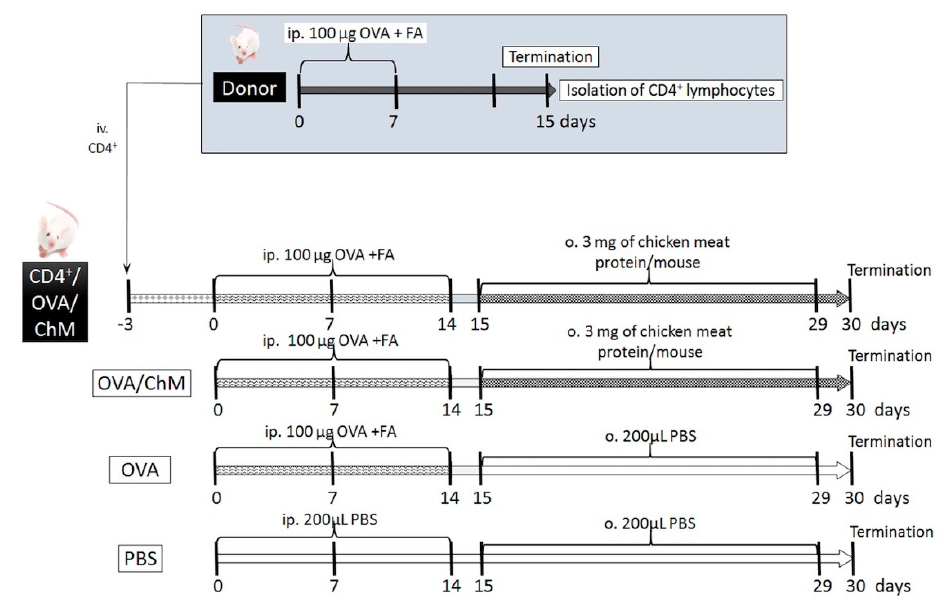
Figure 5. Experiment scheme. Abbreviations used: OVA—chicken egg ovalbumin; FA—Freund’s adjuvant; ChM—chicken meat; ip.—intraperitoneally; o.—oral; iv.—intravenously; PBS—phosphate buffered saline.